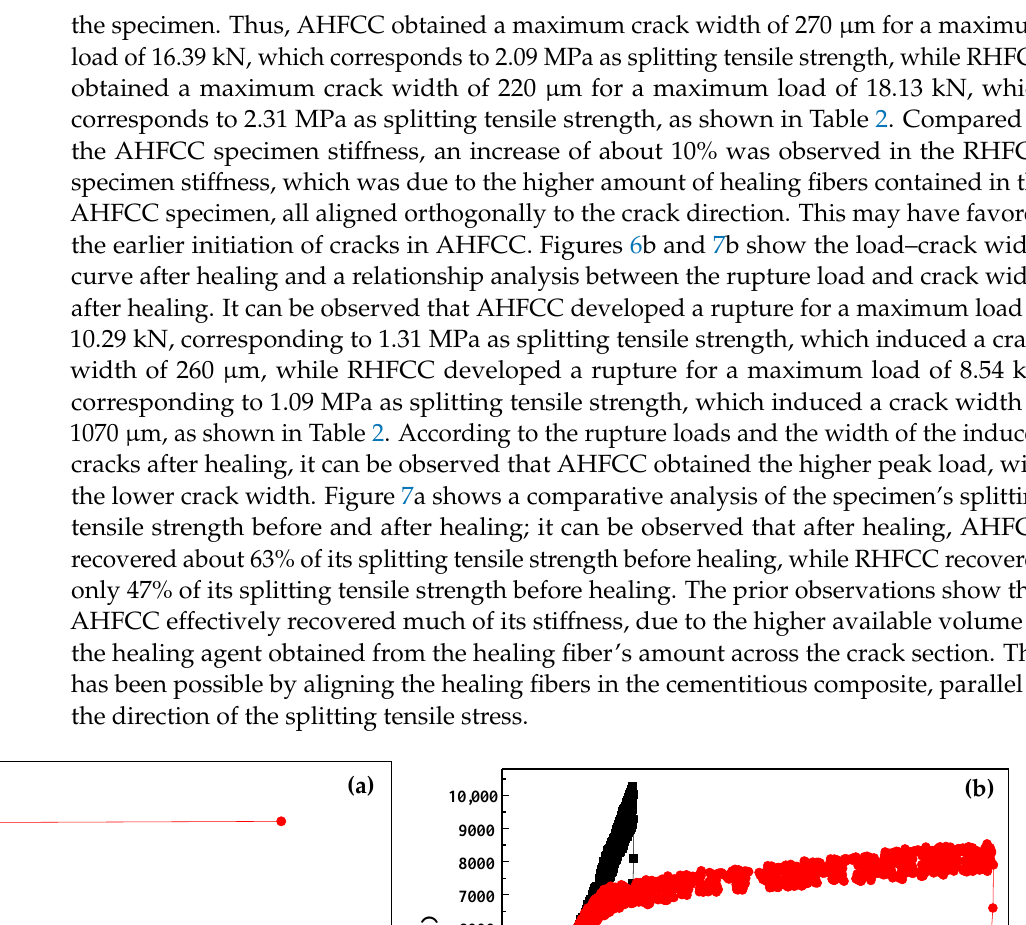
Table 2. Results of the splitting tensile test before and after healing.